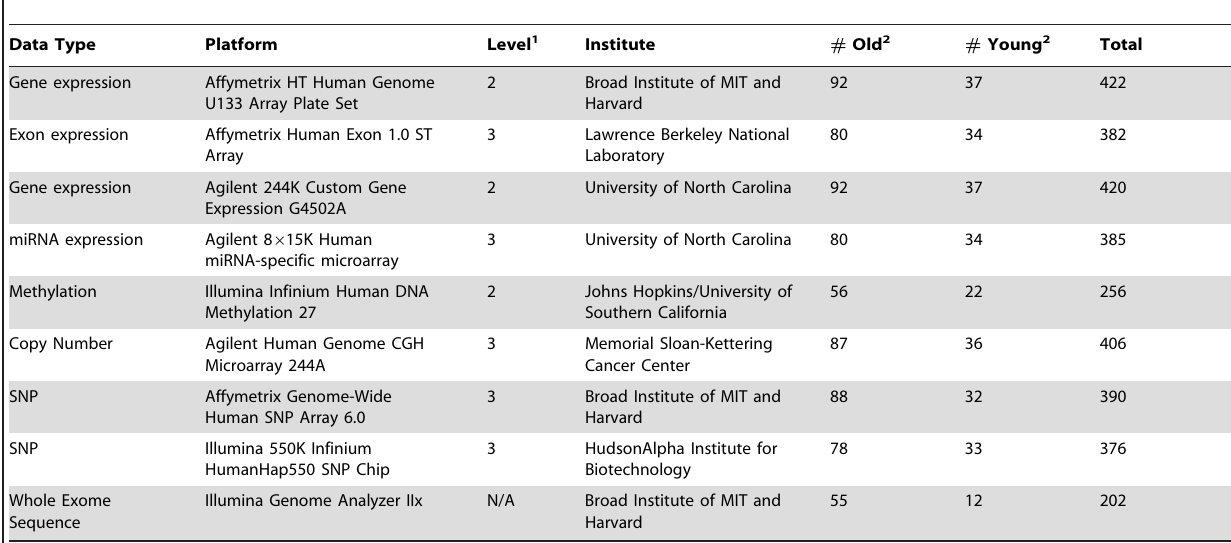
Table 1. Number of GBM samples used in this study (downloaded from the TCGA repository on June 29, 2011, Sample IDs are in Table